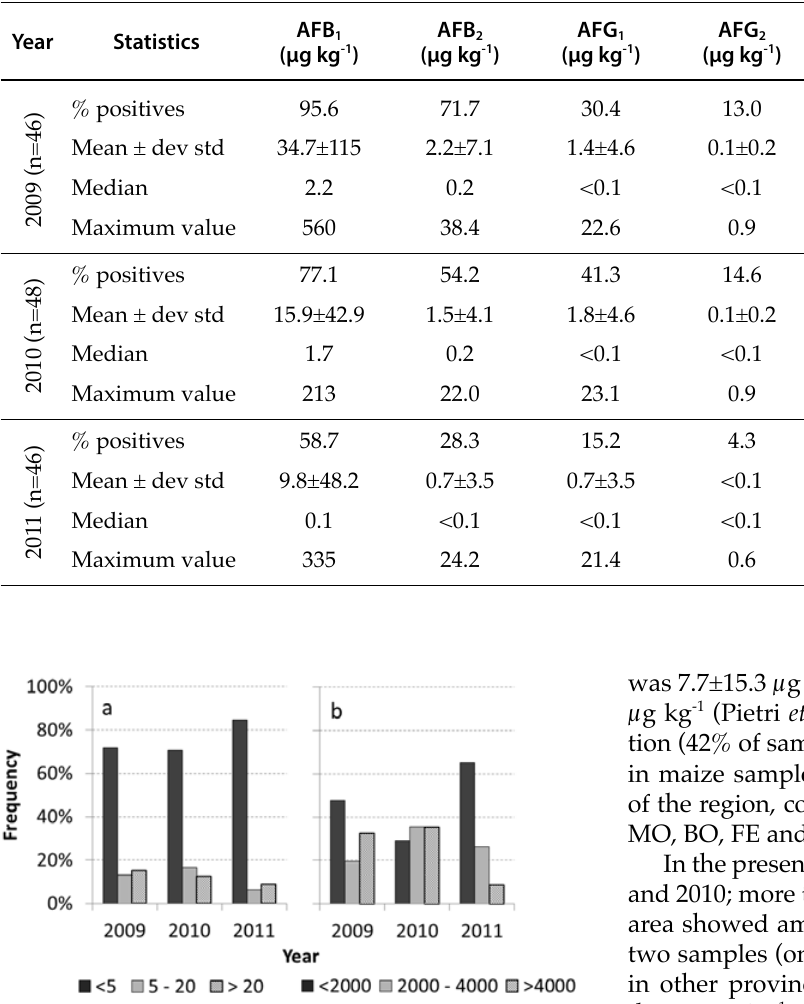
Figure 1. Frequency classes of occurrence (%) for aflatoxin B 1 (a) and fumonisin B 1 +B 2 (b) in maize samples collected in seven provinces of Emilia-Romagna in 2009 (46 sam - ples), 2010 (48 samples) and 2011 (46